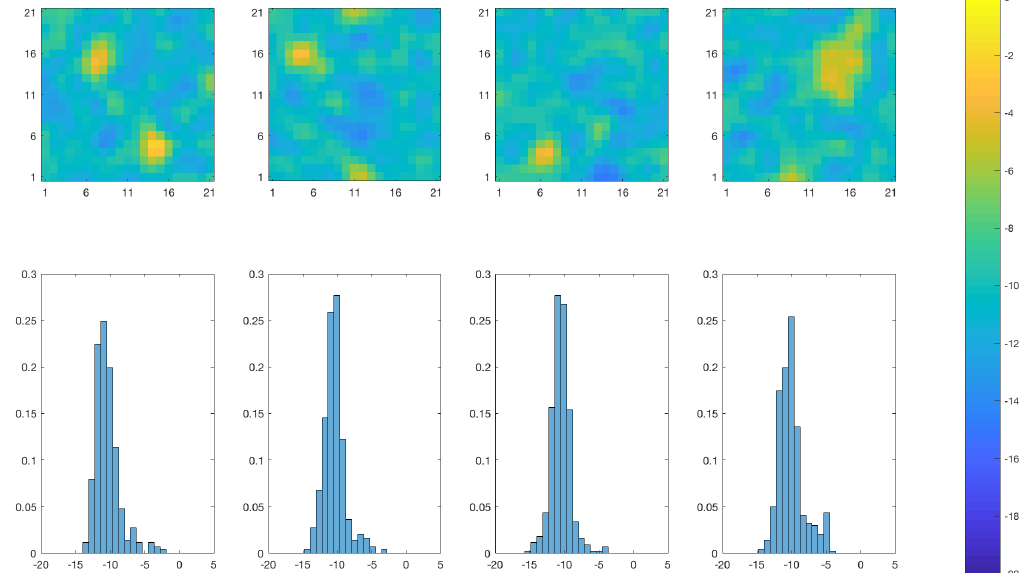
Figure 5. Realizations from the initial selection-Gaussian distribution of the log diffusivity f ( log ( λ )) at time T = 0 (upper panels) and associated spatial histogram (lower panels). Lower panels: the horizontal axes represent the log-diffusivity, the vertical axes represent the relative prevalence of each log-diffusivity value for the realization in the panel right